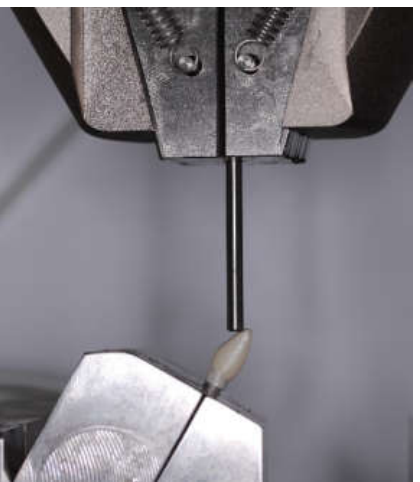
Figure 3. Three groups of zirconia abutments used: All-Zr (a), ASC-Zr (b), and AM-Zr abutments (c).